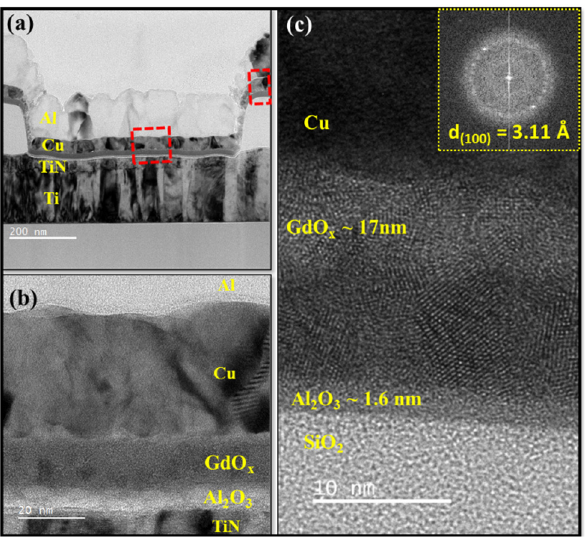
Figure 1. TEM characterization of the S2 memristors with a typical size of 0.6 × 0.6 µm 2 . ( a ) Cross-sectional TEM image of a pristine memristor. HRTEM images show at ( b ) inside and ( c ) outside of the via-hole regions. The inset of ( c ) shows the fast Fourier transform (FFT) image of GdO x film. The ring pattern in FFT indicates polycrystalline of GdO x film.